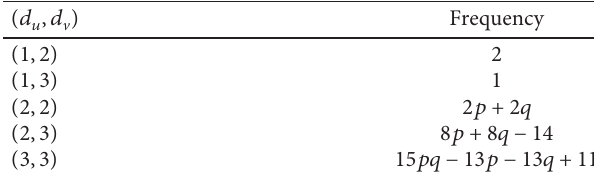
Figure 8: Si Table 2: Degree-based edge partition of Si